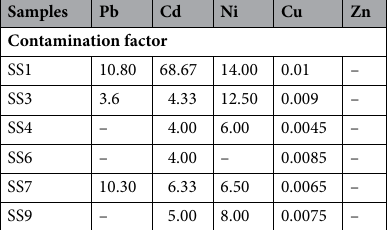
Table 7. Contamination factor of water samples.